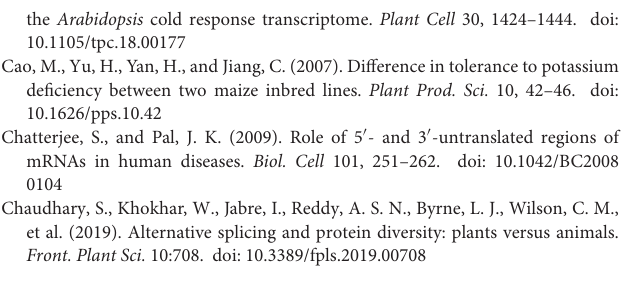
Supplementary Figure 1 | SUPPA2 prediction results of AS events. Different combine sets including different tissues (Root and Shoot), conditions (CK and treatment), and total samples were separately generated. Supplementary Figure 2 | ASprofile prediction results of AS events. Different combine sets including different tissues (Root and Shoot), conditions (CK and treatment), and total samples were separately generated. Supplementary Figure 3 | The proportion of DAS genes in DE genes and non-DE genes in shoot and root under low K + stress condition. Supplementary Figure 4 | Expression level of HAK5 in shoot and root of tobacco seedlings under control and low K + conditions. Supplementary Figure 5 | The distribution of DAS and DE transcription factors among gene families. Supplementary Figure 6 | AS of two ARF genes under K + deficiency conditions in tobacco root. Visualization of the exon-intron structure of representative transcripts for ARF16 (A) and ARF9.2 (B) genes in root under K + deficiency conditions. Sashimi plots show the number of RNA-seq reads mapping to loci associated with AS events. The heights of the bars represent RPKM. Structure diagrams below the sashimi plots show the 5 (cid:48) UTRs (green), coding exons (blue), 3 (cid:48) UTRs (red), and specific protein domains (purple, orange) in major transcript isoforms. Upper numbers in the sashimi plots indicate the inclusion counts (IJC) and lower numbers indicate the skipping counts (SJC) as described in Figure 3A . CK: control condition; LK: low K + stress; IncLevel: inclusion level. Supplementary Table 1 | Summary of RNA-Seq results. Supplementary Table 2 | GO enrichment results of DAS and DE genes in shoot and root. Supplementary Table 3 | Transcription factors in response to low K + in